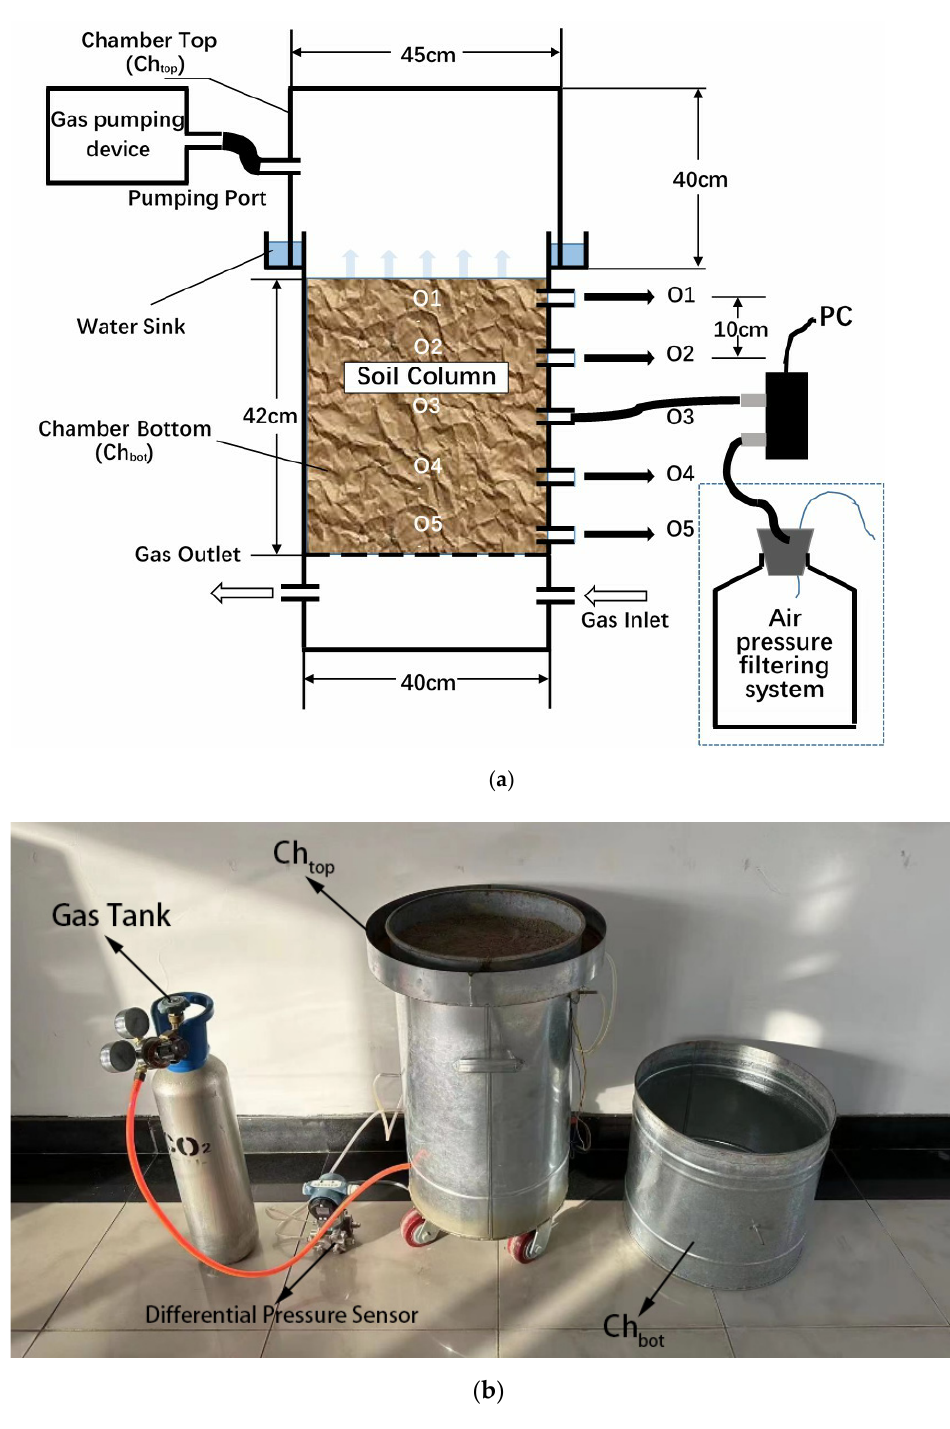
Figure 2. ( a )Illustration of self-designed gas chamber that is connected with other experimental in- struments. The pumping port of the removable cylindrical gas chamber cover (Ch top ) is connected to an external pressure pump, and the outer tube extending from O1 to O5 layers inside the lower bottom closed cylindrical barrel (Ch bot ) can be connected to one end of the differential pressure transducer, and the other end of the differential pressure sensor is connected to the reference chamber (air pressure filtering system, see the dashed box in the figure), which transmits CO 2 by venting to the inlet port of the Ch bot , and the outlet port is used to balance the pressure difference caused by the ventilation. Data collected from pressure transducer were transferred to PC (i.e., personal com- puter).( b )Physical diagram of the experimental setup, from left to right, are gas tank, differential pressure sensor, Ch bot and Ch top , respectively, gas pumping device and PC are excluded.